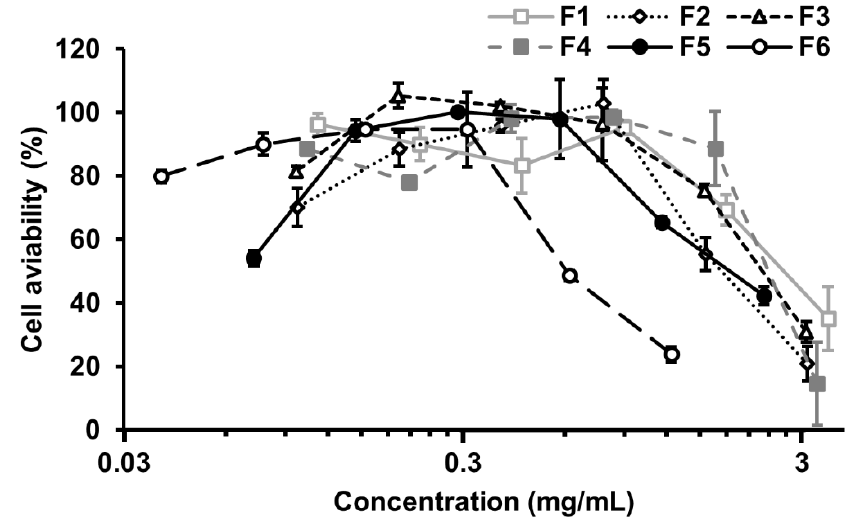
Figure 4. Cytotoxicity of BLG nanoparticles fractions towards MDCK cells. Concentration–response curve to obtain TC 50 value. Values are expressed as the mean ± SD ( n = 3).